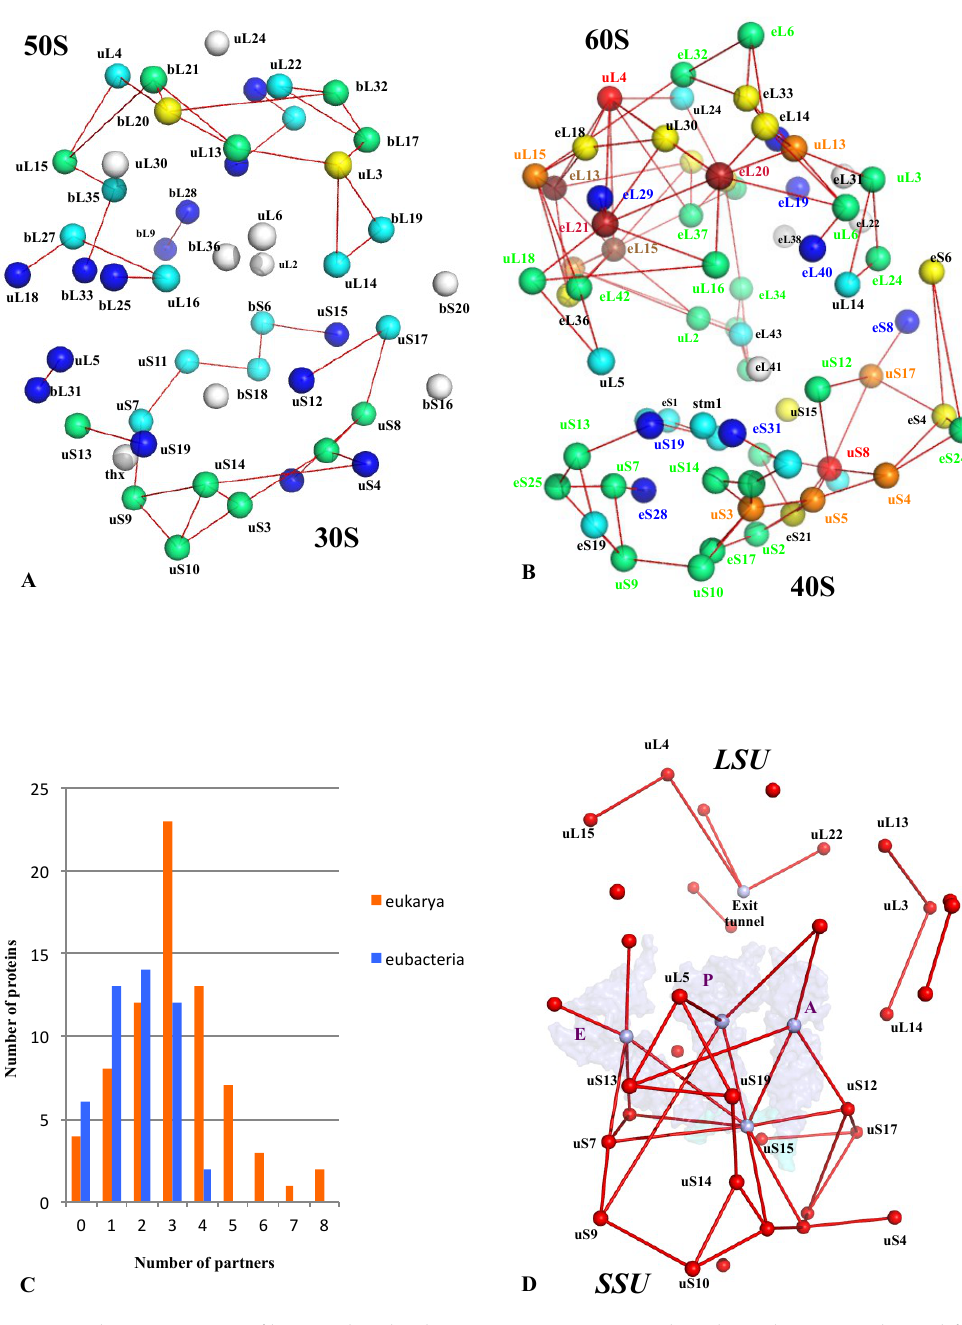
Figure 8. The comparison of bacterial and eukaryotic r-protein networks. Three-dimensional simplified representations of the bacterial ( A ) eukaryotic ( B ) r-protein networks. The centres of mass of the r-proteins (coloured spheres) are connected by red lines. The proteins are coloured in the function of their number of interacting partners. White: 0; blue: 1; cyan: 2; green: 3; yellow: 4; orange: 5; brown: 6; red brick: 7; red: 8. ( C ) 3D simplified representation of the universal network; the three tRNAs and the mRNA are represented by transparent surfaces. ( D ) Histogram reporting the degree distribution (inter-protein contacts) in bacterial (blue) and eukaryotic (orange) ribosome r-protein networks.